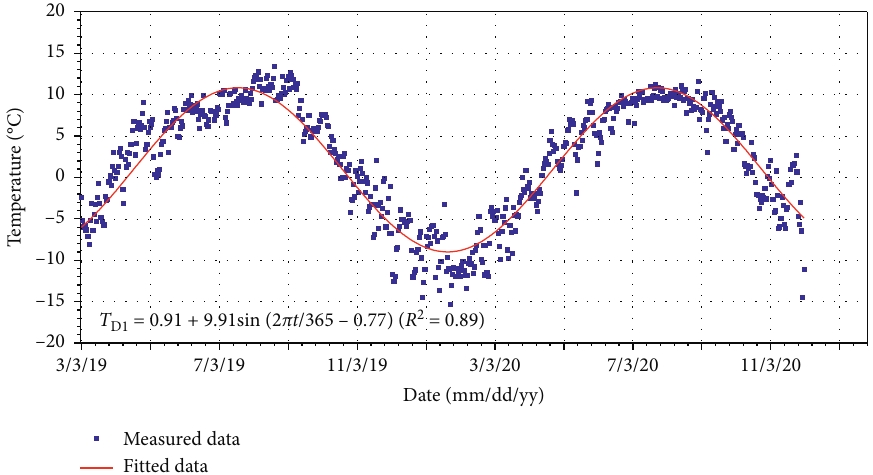
Figure 2: Observation of air temperature at D1 inside the tunnel monitored with a temperature sensor.